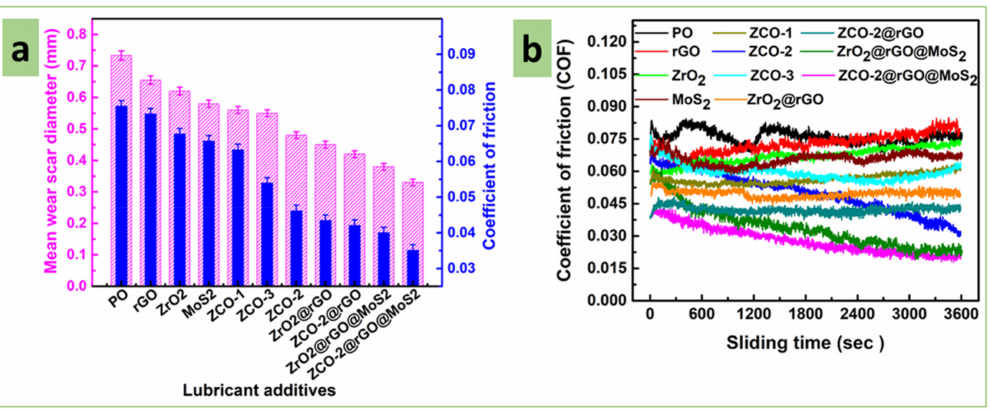
Figure 6. Variation in tribological parameters in the absence and presence of di ff erent nano additives (0.125% w / v) in para ffi n oil: Load, 392 N; sliding speed, 1200 rpm; temperature, 75 ◦ C; sliding duration, 60 min; concentration of additives, 0.125% w / v. ( a ) Mean wear scar diameter and the average coe ffi cient of friction, ( b ) coe ffi cient of friction as a function of sliding